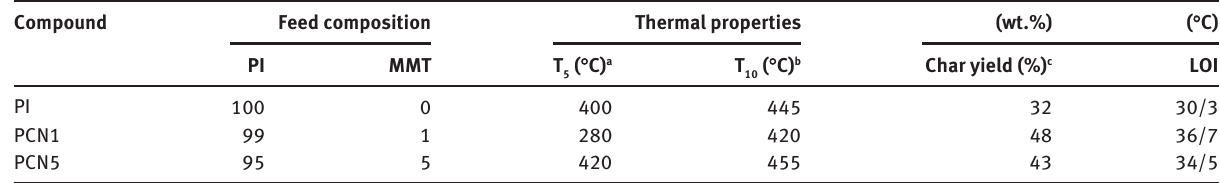
Table 1 Thermal behavior of PI, PCN5, and PCN10.